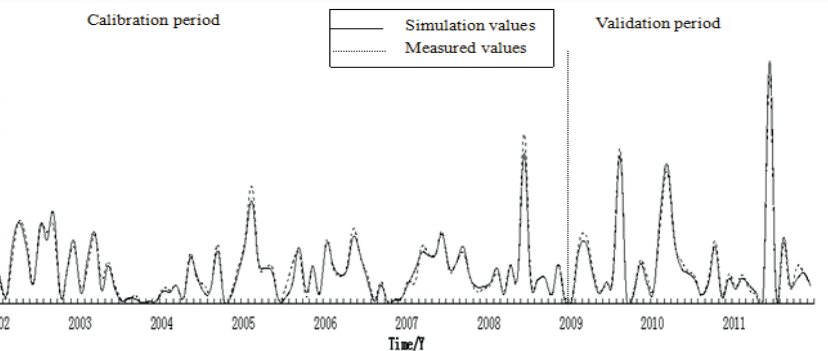
Fig. 2 Simulated and observed results of flow in calibration period and validation period.